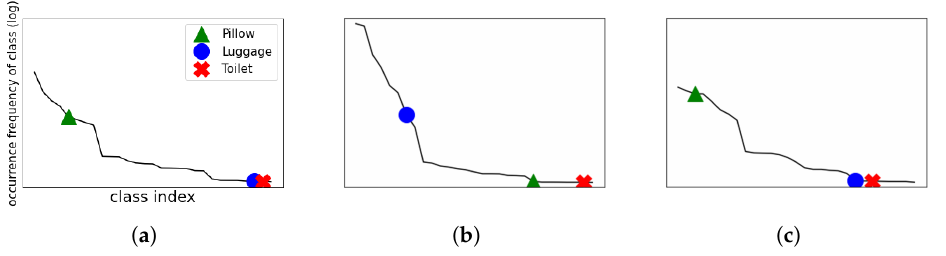
Figure 2. Class imbalance in different environments. Class distributions of ( a ) the entire Objects365 data, ( b ) airport terminal environment data, and ( c ) hospital room environment data. Such a class imbalance shows different characteristics depending on the